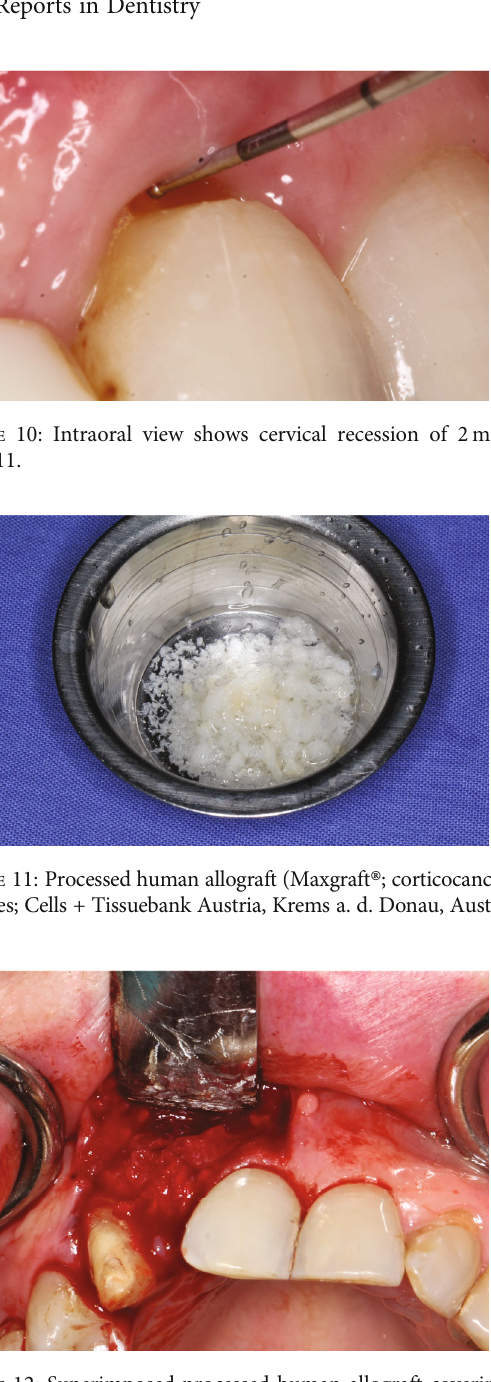
Figure 12: Superimposed processed human allograft covering the dental implant.